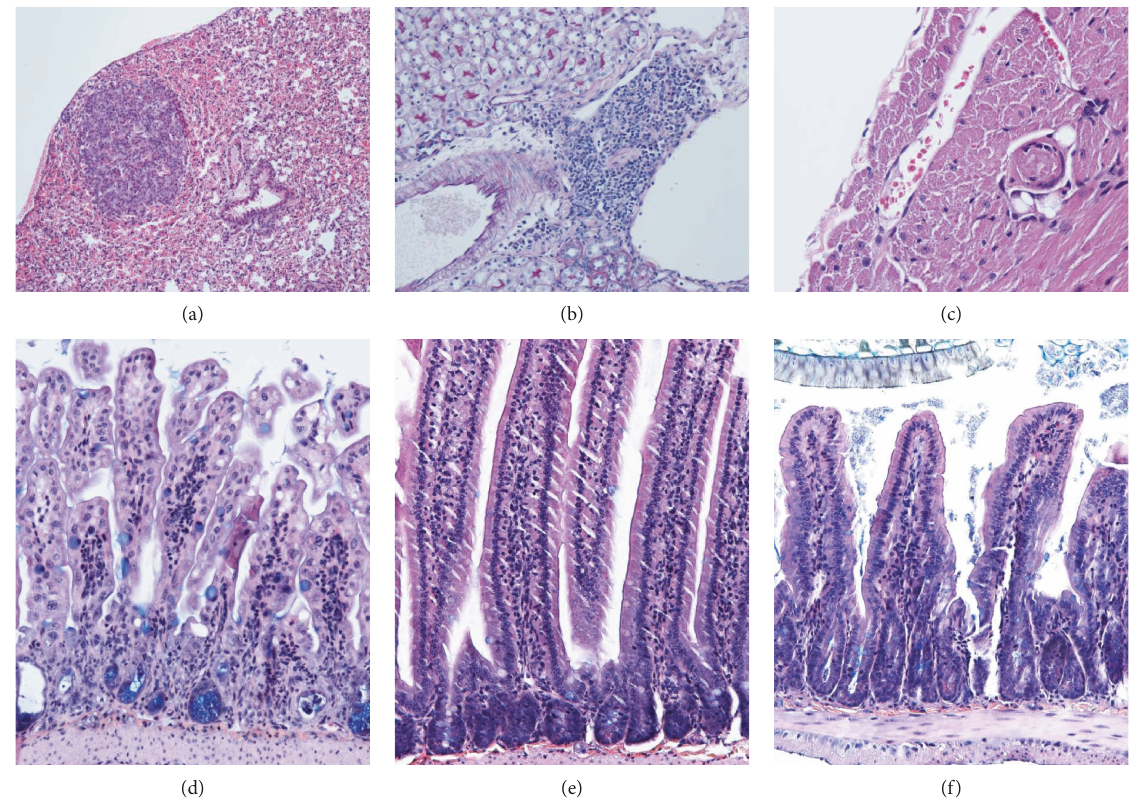
Figure 1: hMSC treatment in ATG immunosuppressed and cisplatin-treated BALB/cOlaHsd male mice 3 months after transplantation revealed unexpected pathology. (a) Subpleuraly, a homogeneous solid tumor (diameter 0.5mm) with rare mitosis and uniform nuclei was sharply demarcated from the surrounding tissue in the lung of hMSC treated mouse (HE, magni fi cation 100x). (b) In fl ammatory cells (lymphocytes, plasma cells, and histiocytes) surrounding the arteriola and vein in the kidney of the hMSC-treated mouse (PAS, magni fi cation 200). (c) Thrombus in the small artery of the right ventricle wall of ATG+cisplatin-treated mouse (HE, magni fi cation 400x). (d) Moderate chronic jejunitis in hMSC-treated mouse — note atrophy of crypts and loss of architecture of villi (Kreyberg, magni fi cation 400x). (e) Jejunum in the healthy untreated mouse (Kreyberg, magni fi cation 400x). (f) Jejunum of the cisplatin-treated mouse. Restitution of the mucosa is seen; however, the height of villi is decreased compared to healthy mice (Kreyberg, magni fi cation